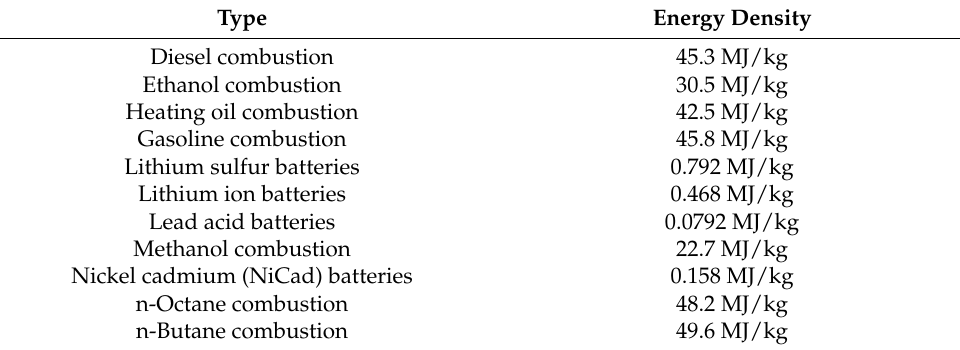
Figure 1. Different microelectromechanical systems, ( a ) Micro-sensors, ( b ) Micro-aircrafts, ( c ) Micro- motors. Table 1. Different energy densities at 1 atm and 298